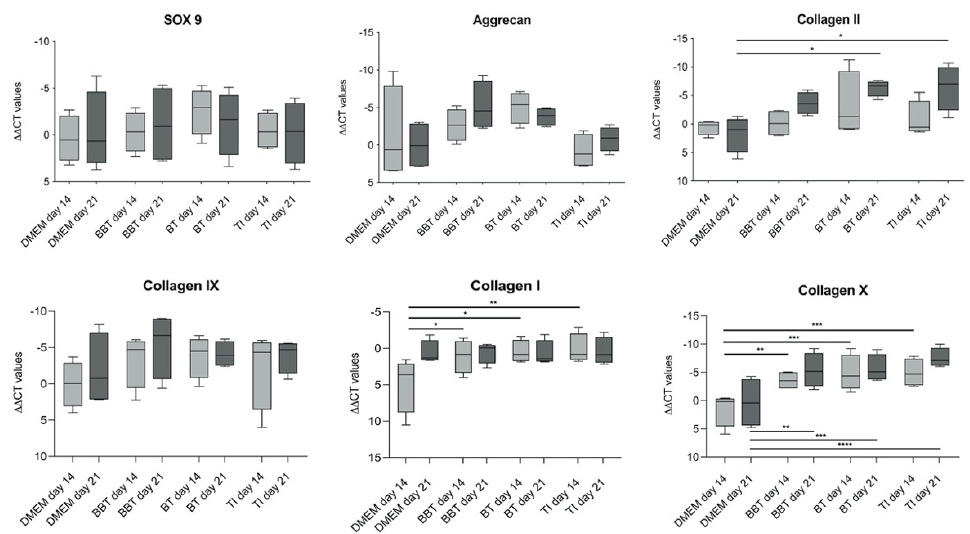
Figure 5. RT-PCR analyses of the in vitro PU-fibrin constructs: Relative quantification was performed and is presented as values ( ∆∆ CT values) normalised to the gene expression of the housekeeping gene GAPDH and day 0. SOX-9: No significant differences during the time course and between the different groups. Aggrecan: No significant difference during the time course compared to the control, but a tendency towards increased gene expression in the BBT and BT groups. Collagen II: Significant increase in the BT and TI groups compared to the control after 21 days. Collagen IX: A tendency to increase was also detectable, but no significant difference was evident. Collagen I: After an initial increase compared with the control, no relevant change of gene expression was determined in any group compared to the control group after 21 days. Collagen X: Significant increase in the growth factor groups. Box-Whisker plots show the median, 1st quartile, 3rd quartile as well as minimum and maximum values of ∆∆ CT, significance is indicated by asterisks (* p < 0.05, ** p < 0.01, *** p < 0.001, **** p < 0.0001).